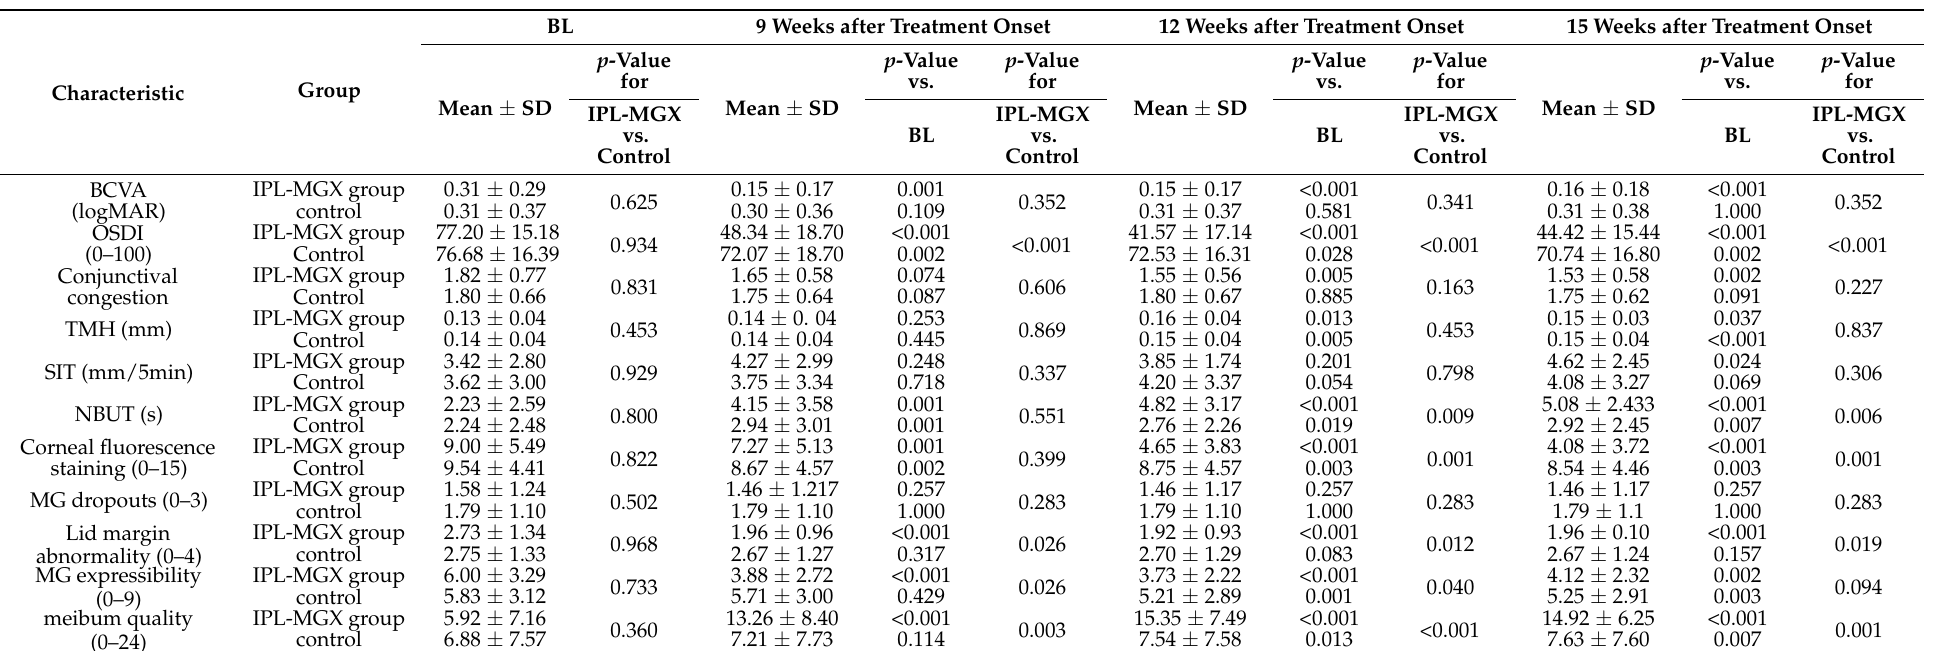
Table 2. Characteristics of the intense pulsed light (IPL)-meibomian gland expression (MGX) and control groups before and after